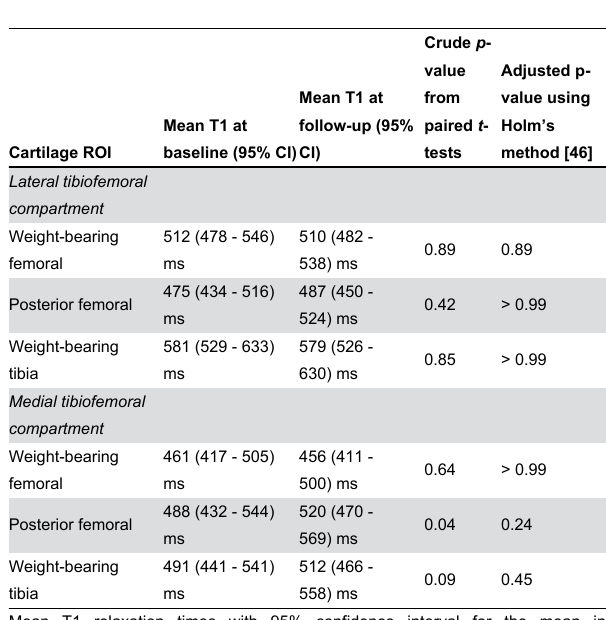
Table 1. Mean dGEMRIC T1 relaxation times (ms) at baseline and